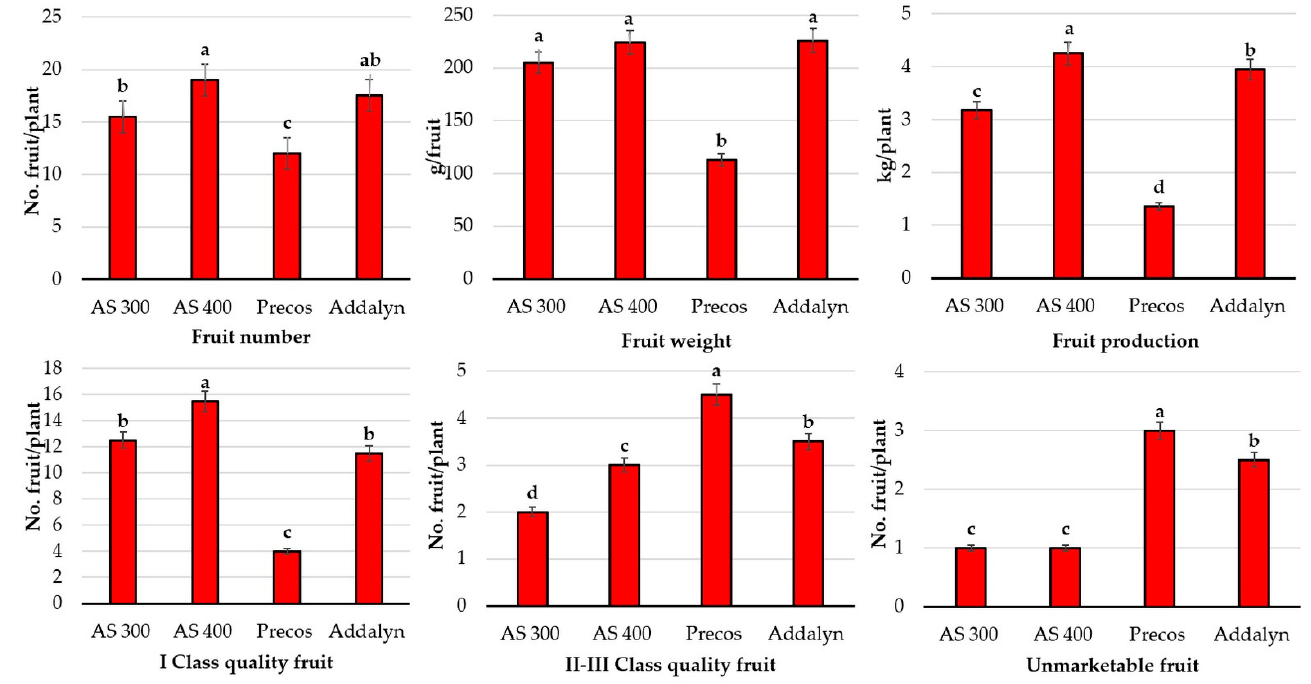
Figure 3. The main elements of productivity and the classification of tomato fruits in quality classes and unmarketable fruits in four tomato genotypes. All values are expressed as mean ± SEM. For each trait, any two means followed by the same letter are not significantly different (Duncan’s test, α < 0.05).